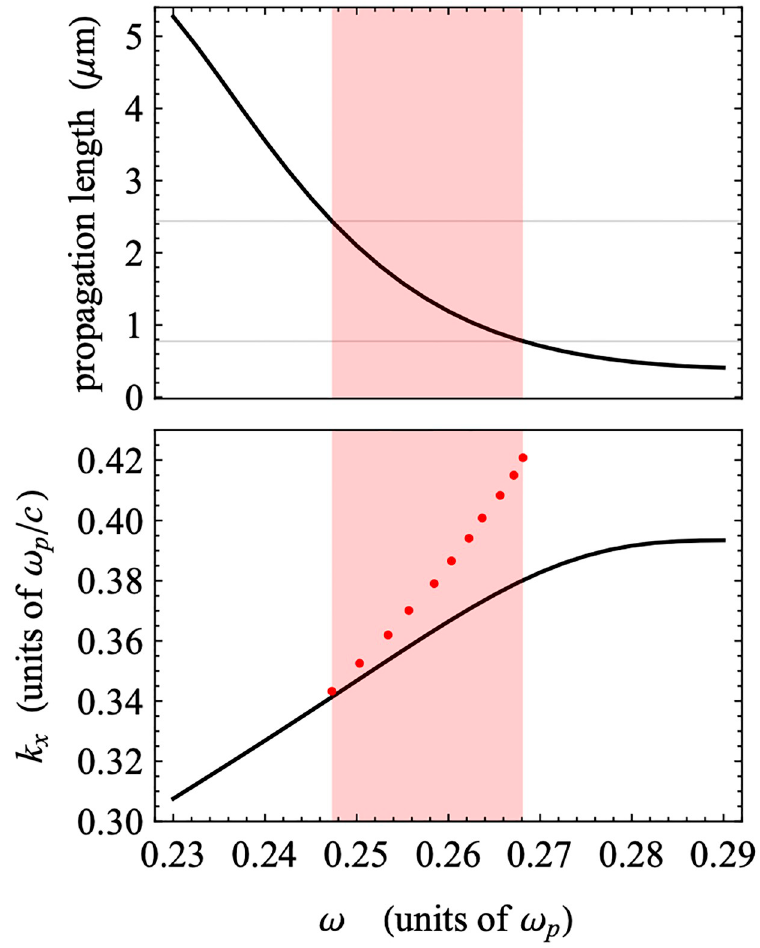
Fig 8. Calculated propagation length as a function of frequency (top panel) and undamped dispersion relationship (bottom panel). Red dots indicate the minima of the experimental ATR scans (see Fig 5).